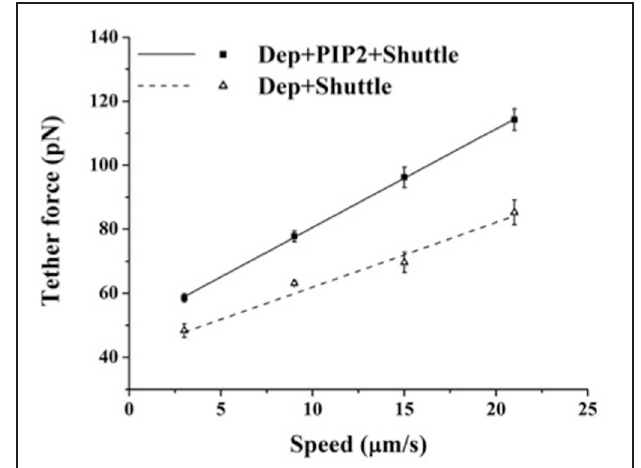
FIGURE 5 | Effect of exogenous PIP2 on the tether force upon cholesterol depletion. Tether force versus pulling speed in BAEC treated with M β CD followed with the delivery of PIP2-Shuttle or only Shuttle. The two curves are statistically different ( p < 0 . 05). (Values of the slopes are given in the text). Error bars represent